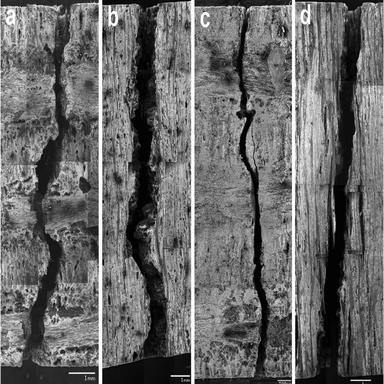
Low magnification SEM images of Cf-HfB2 powder composites after tensile testing at 1000 °C. (a) Strongest sample; cross-section (b) strongest sample; top surface, (c) weakest sample; cross-section, (d) weakest sample; top surface.